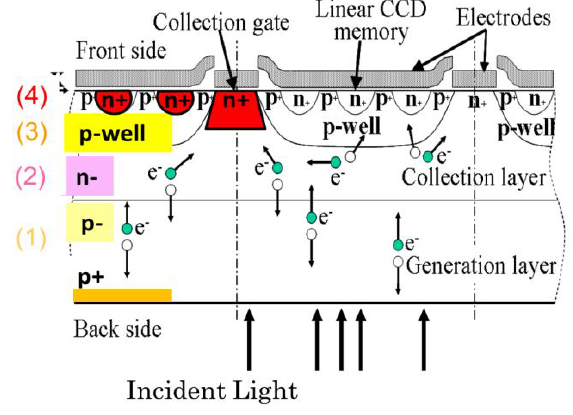
Figure 2. BSI ISIS with a ―Tetratified‖ structure (A-A’ cross section of Figure 1)